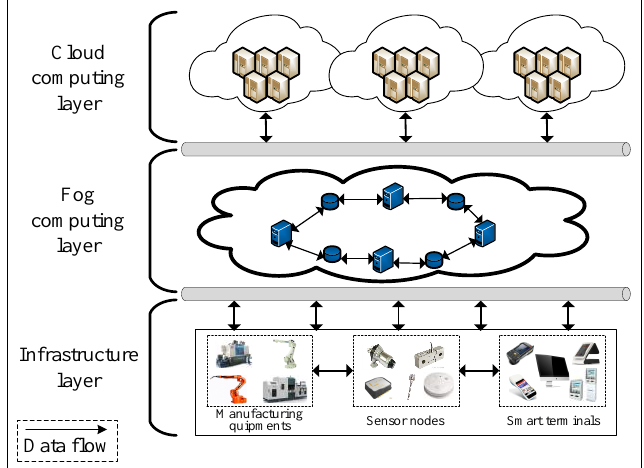
Figure 1. The architecture of intelligent production line system architecture based on cloud-fog computing.